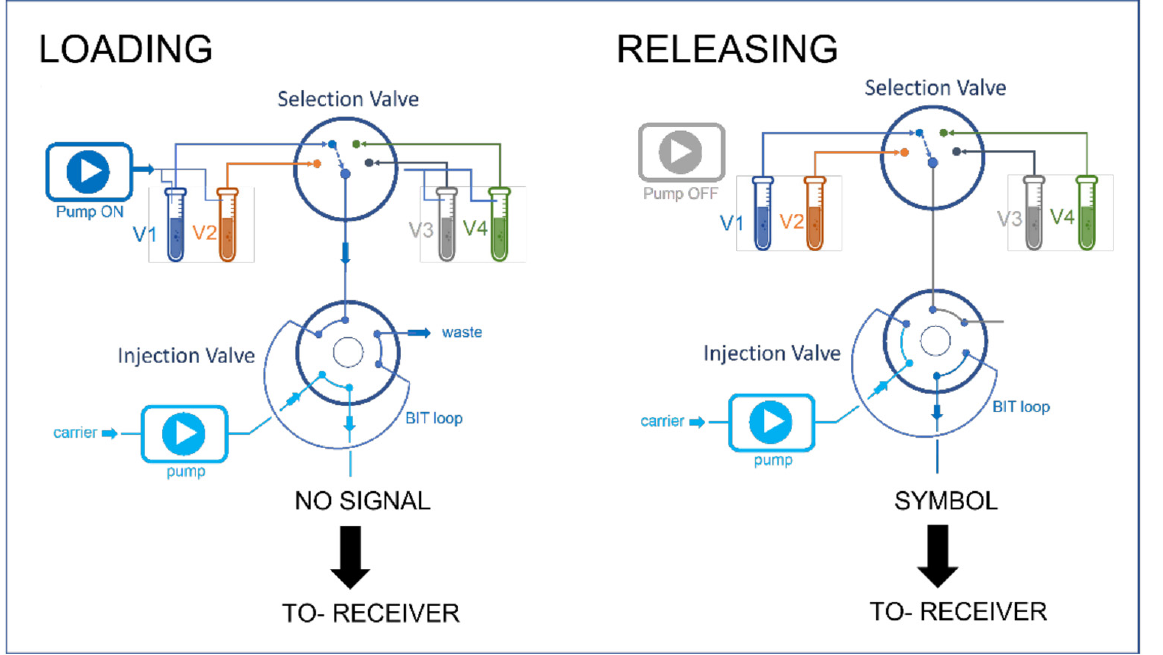
Figure 2. Schematic representation of the loading and realizing steps coordinately governed by selection and injection